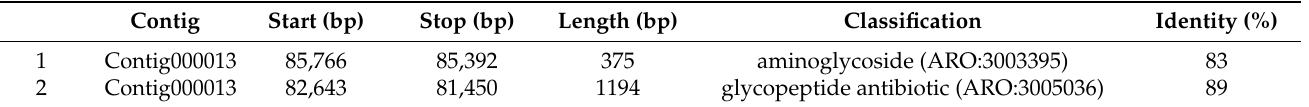
Table A8. Dactylosporangium sp. AC04546 antibiotic resistant genes identified from CARD database.